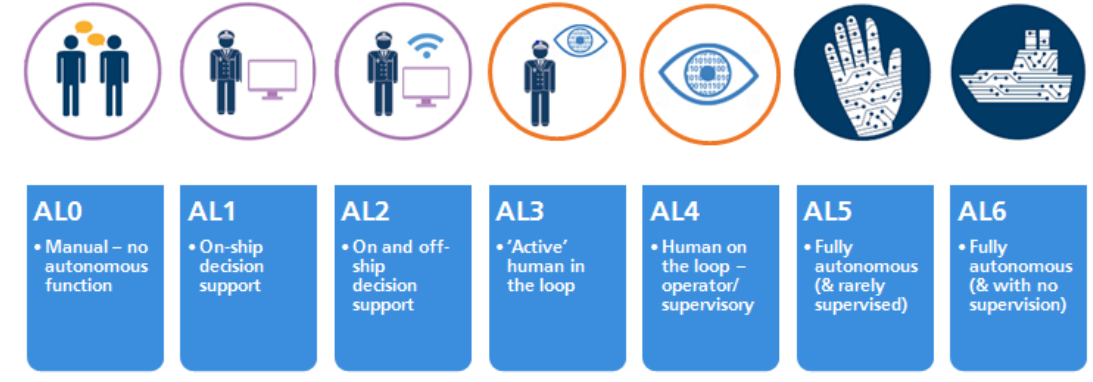
Figure 1: Levels of autonomy for maritime vessels. Courtesy of Lloyd’s